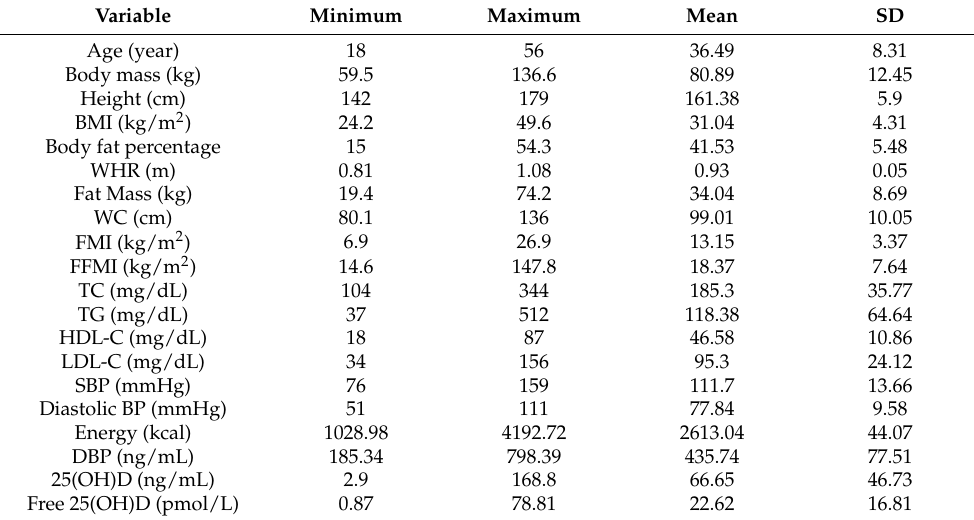
Table 1. Characteristics and anthropometric parameters, vitamin D-binding protein, and vitamin D, of the target population.